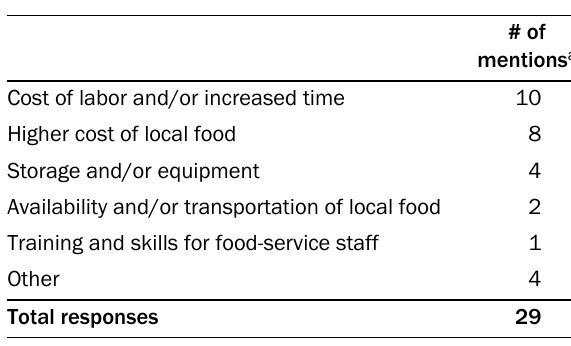
Table 2. Summary of Barriers to Providing